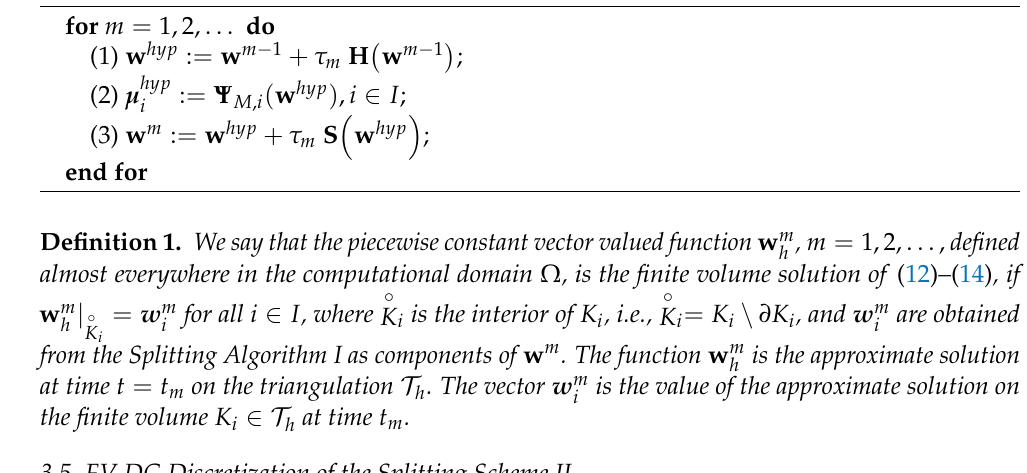
Algorithm 2 Euler